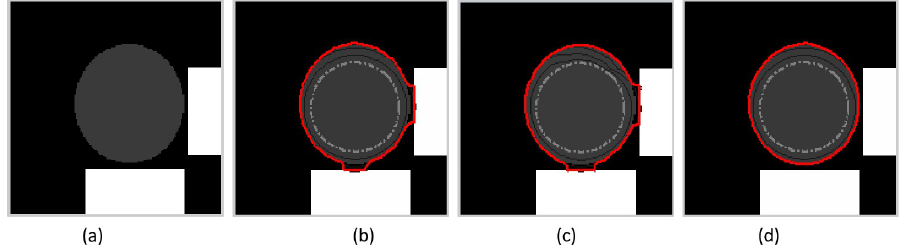
Fig 4. Experiment on weak edge preservation. (a) Original image. The segmentation results of (b) the GVF snake with μ = 0.05, (c) the VEF snake, and (d) the MCONVEF snake with k = 0.1, h = 0 and L = 2. The gray dash point circles are the initial contours, and the solid lines in red are the converged